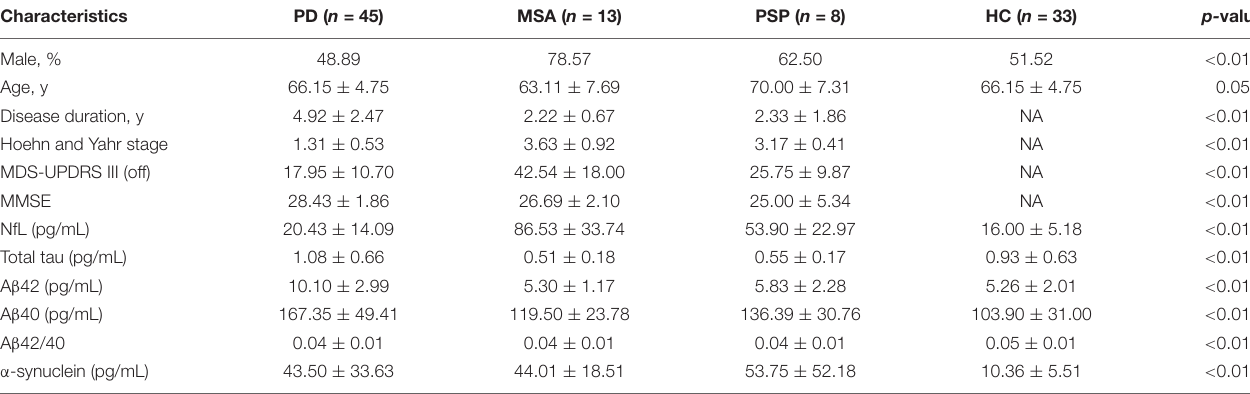
TABLE 1 | Clinical characteristics of study participants.